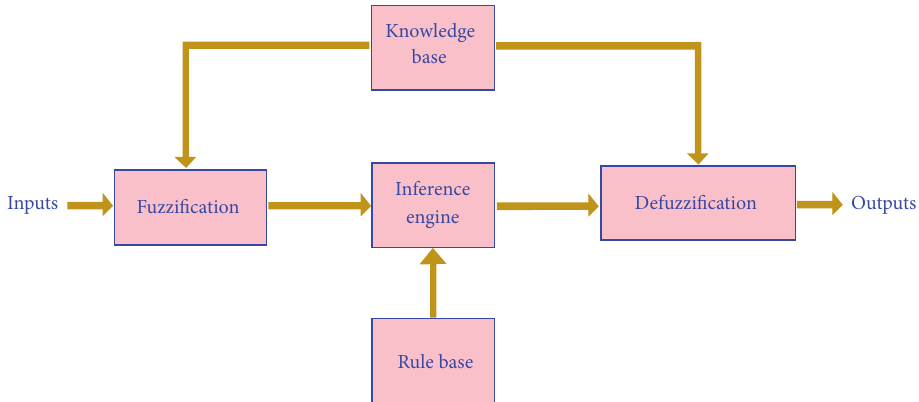
Figure 1: Structure of a fuzzy inference